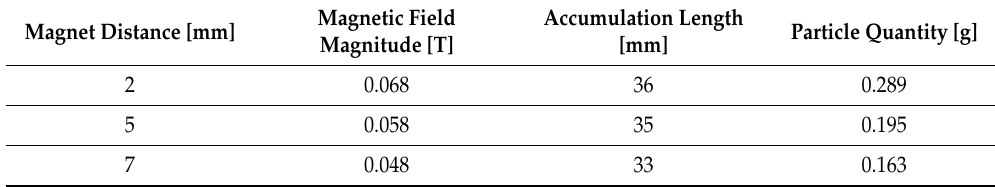
Table 7. Characteristics of the particle accumulation for di ff erent magnet